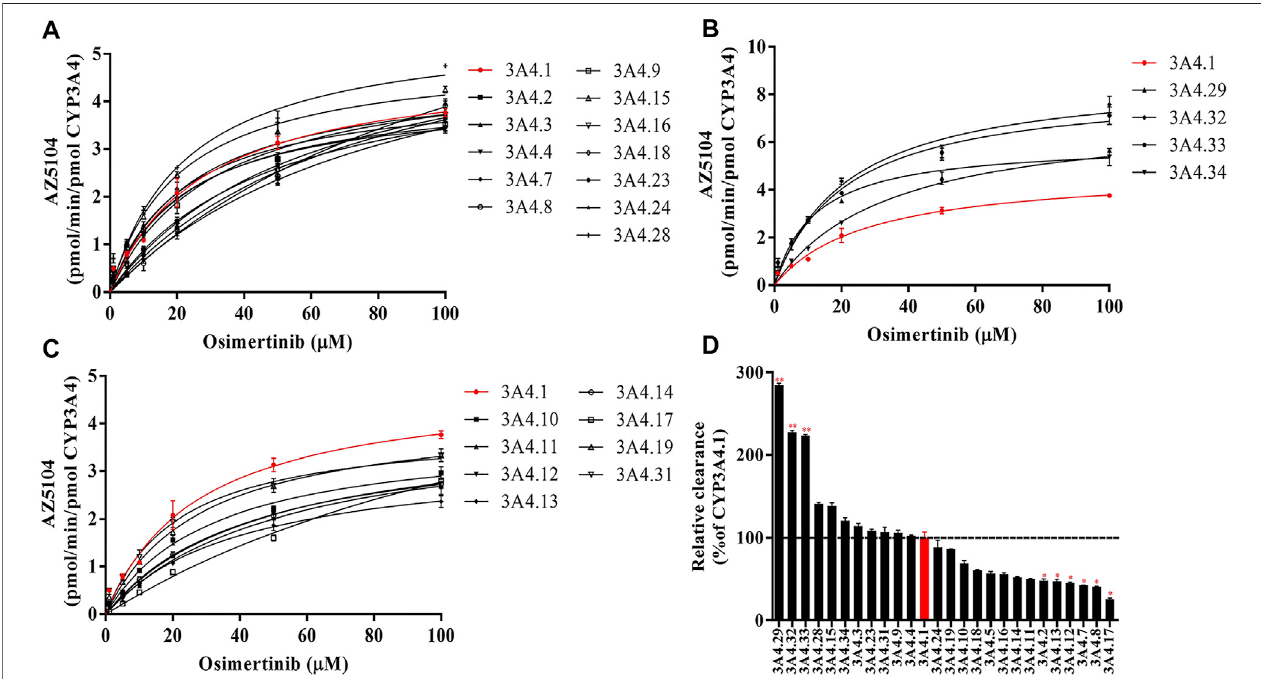
FIGURE 1 | Michaelis – Menten curves of the enzymatic activities of the wild-type CYP3A4 and other CYP3A4 variants in the metabolism of osimertinib (A – C) and relative clearance of CYP3A4 variants toward the metabolism of osimertinib compared with the wild type (D) . Data are presented as the means ± SD, n = 3. * p < 0.05, ** p < 0.01, *** p <